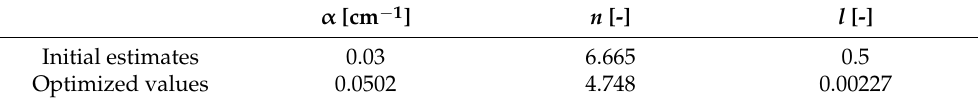
Table 5. The initial estimates and optimized parameter values of Tottori dune sand.